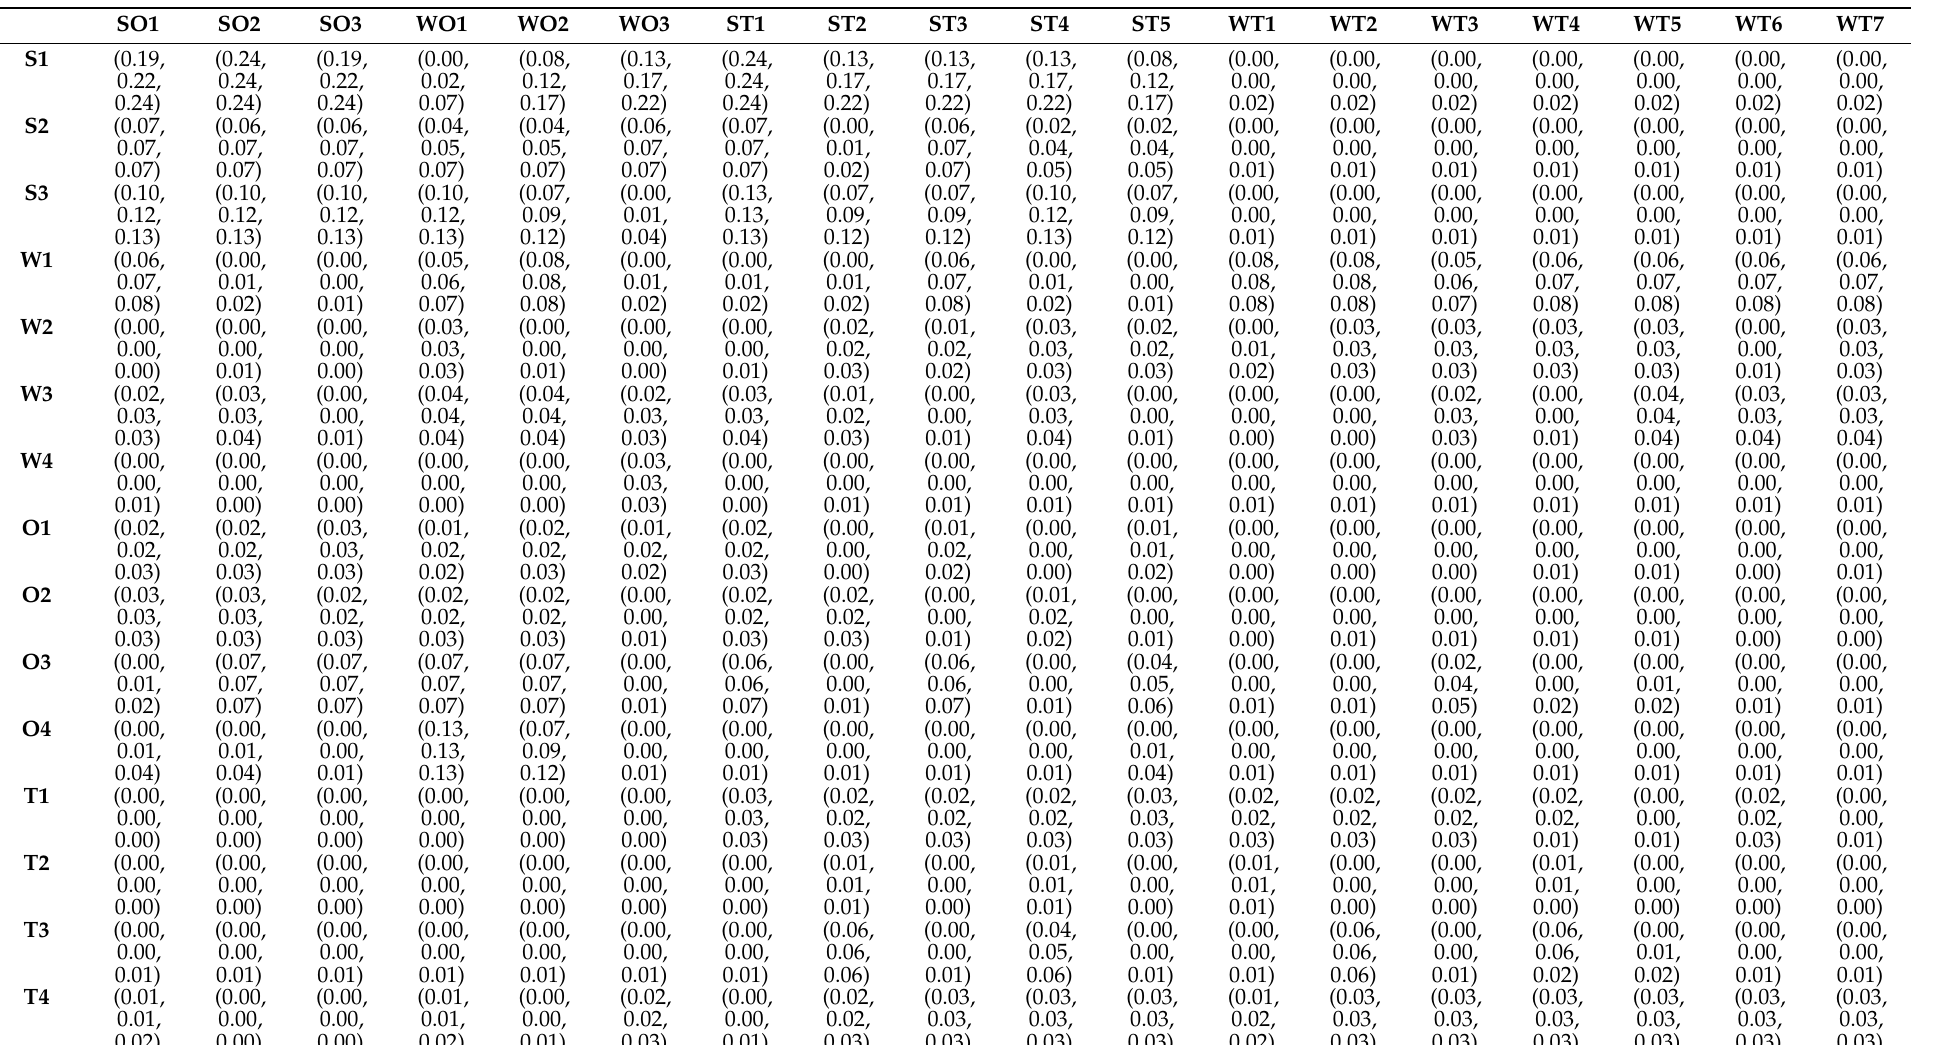
Table A8. Fuzzy weighted decision